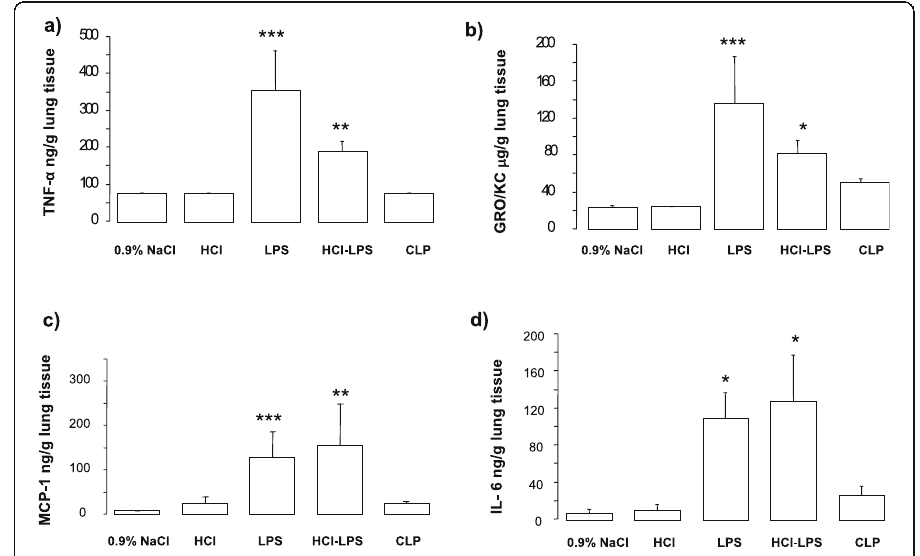
Fig. 4 a Cytokine TNF- α , b GRO/KC, c MCP-1, and d IL-6 concentrations in lung homogenate of animals 24 h after induction of the injury. Data are presented as mean±SEM. TNF- α , LPS *** p < 0.0001 vs 0.9% NaCl, HCl, or CLP; HCL-LPS: * p < 0.001 vs 0.9% NaCl, HCl, or CLP; GROKC, LPS *** p < 0.0001 vs 0.9% NaCl, HCl, or